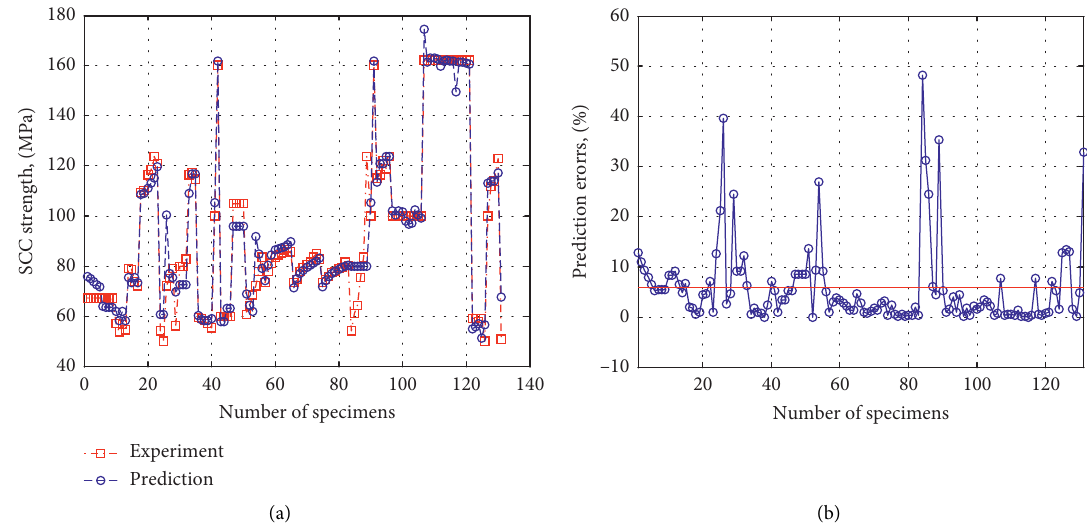
Figure 6: Performance of the ANN model. (a) Experiment versus prediction. (b) Absolute prediction errors.